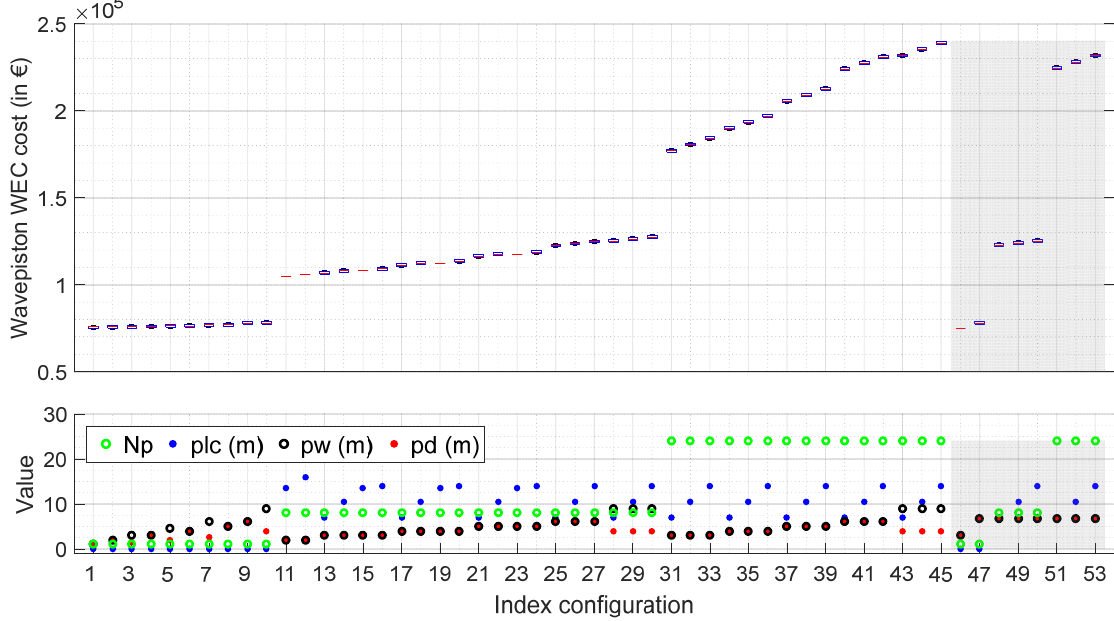
Figure 6. Boxplot that shows the spread of the WEC cost (in €) over the site water depth (see Table 3) clustered per similar configuration of Wavepiston of the other Wavepiston WEC configuration parameters (see Table 2 and Table 3 for parameter definition and values), the grey sections for the elliptical plates.